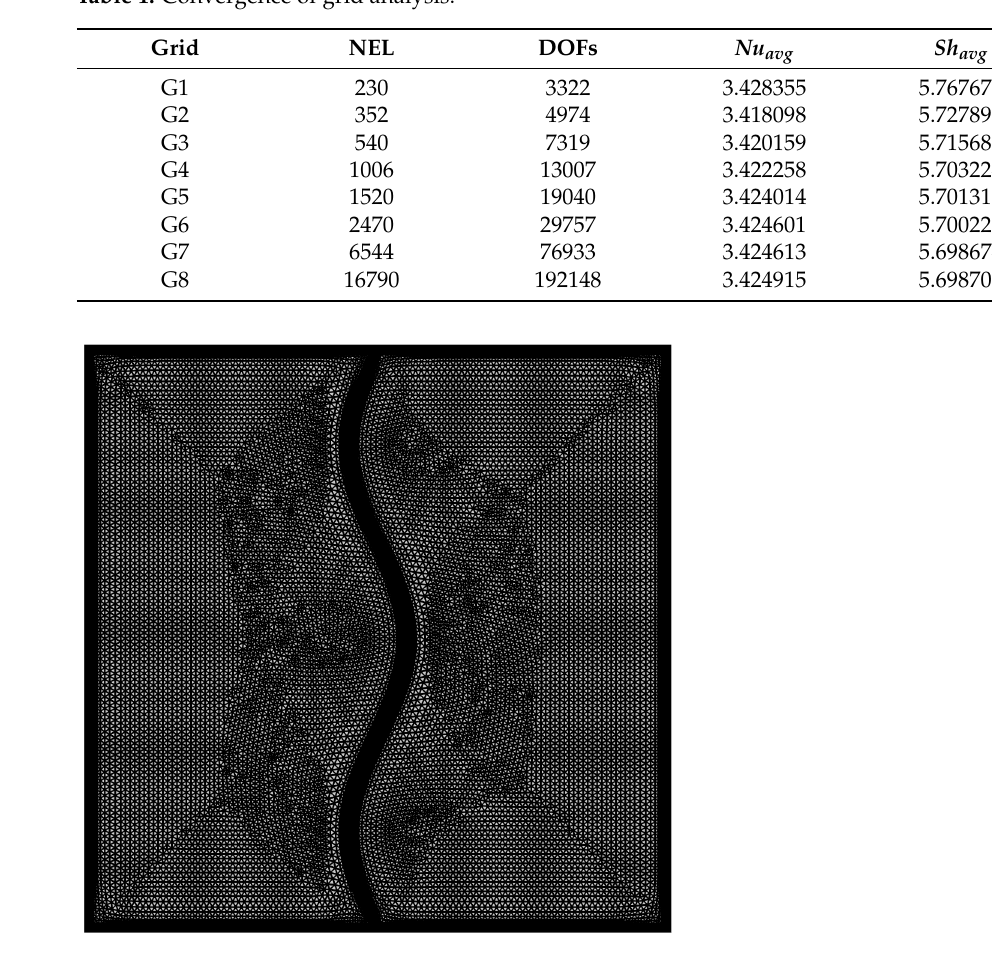
Figure 2. The grid for the proposed model.